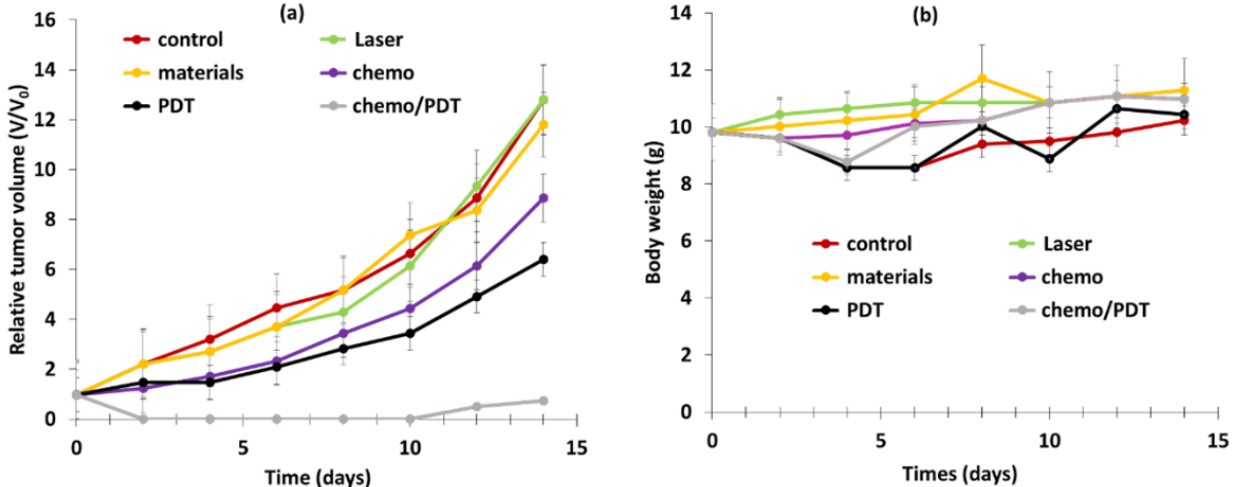
Figure 19. ( a ) Relative tumor volume and ( b ) body relative weight of 6 groups of HeLa tumor-bear- ing mice under various conditions: control, laser (808 nm irradiation and 0.5 W/cm 2 for 10 min), DOX-RB-NH2-UCMS-BA-CD chemotherapy, PDT, chemotherapy + PDT. Adapted from Han et al. [41] .